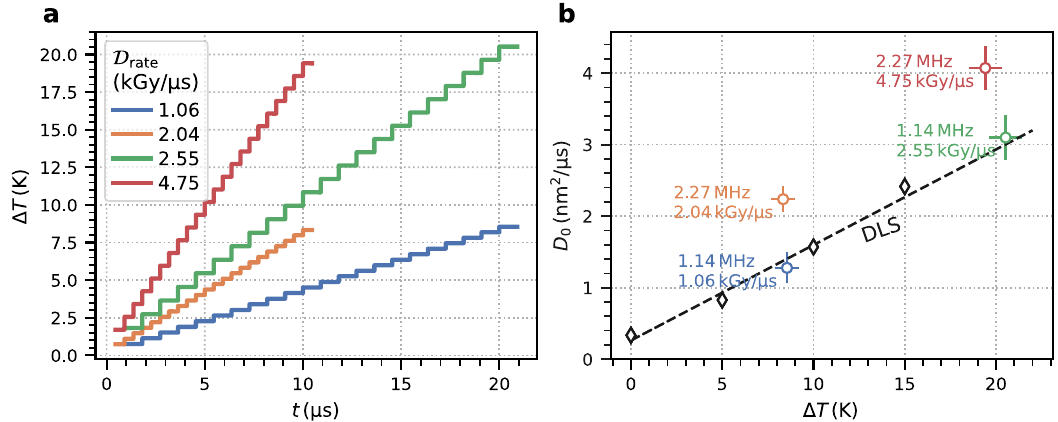
Fig.5|Effectoftemperatureonthedynamics.a Calculatedtemperatureincrease Δ T after20XFELpulsesforthefourdifferentdoserates. b Diamonds:Temperature dependence of diffusion coef fi cients measured by dynamic light scattering (DLS). The dashed black line is a linear fi t to the data. Circles: diffusion constants deter- mined via XPCS and minimum initial dose using the pulse frequencyand dose rate